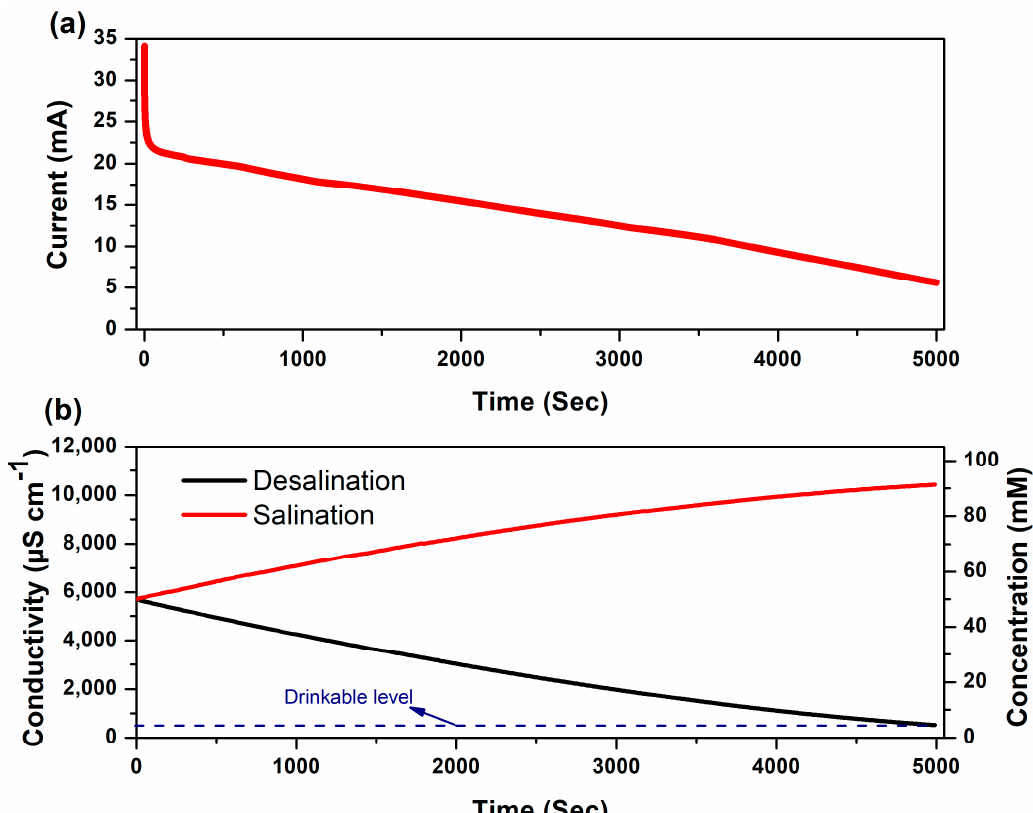
Figure 7. Long-run experiment of desalinating 50 mM saline water to drinkable level: ( a ) I-t curve with 1.5 V cell voltage, and the corresponding ( b ) conductivity and concentration changes with time in the desalination and salination chambers.